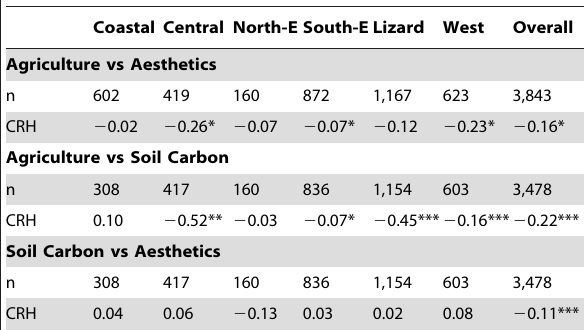
Table 1. CRH correlation test between different ecosystem services across Cornwall, and within different regions